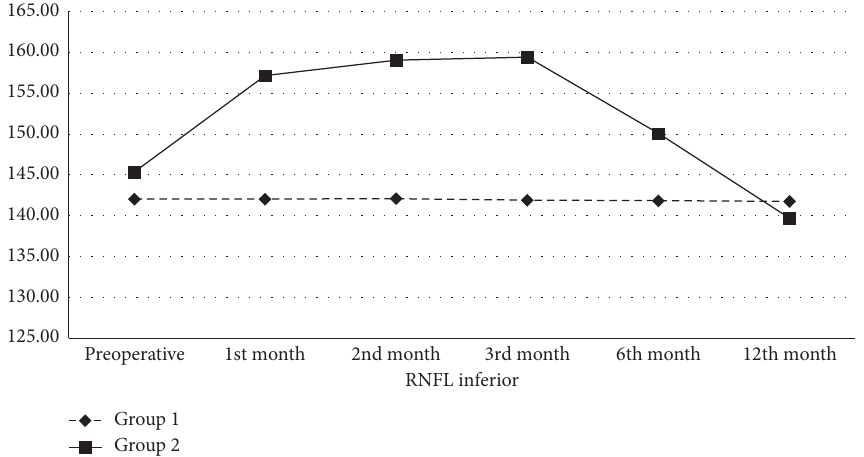
Figure 3: Retinal nerve fiber layer thickness ( μ m) change in the inferior quadrant of the groups. RNFL: retinal nerve fiber layer; μ m: